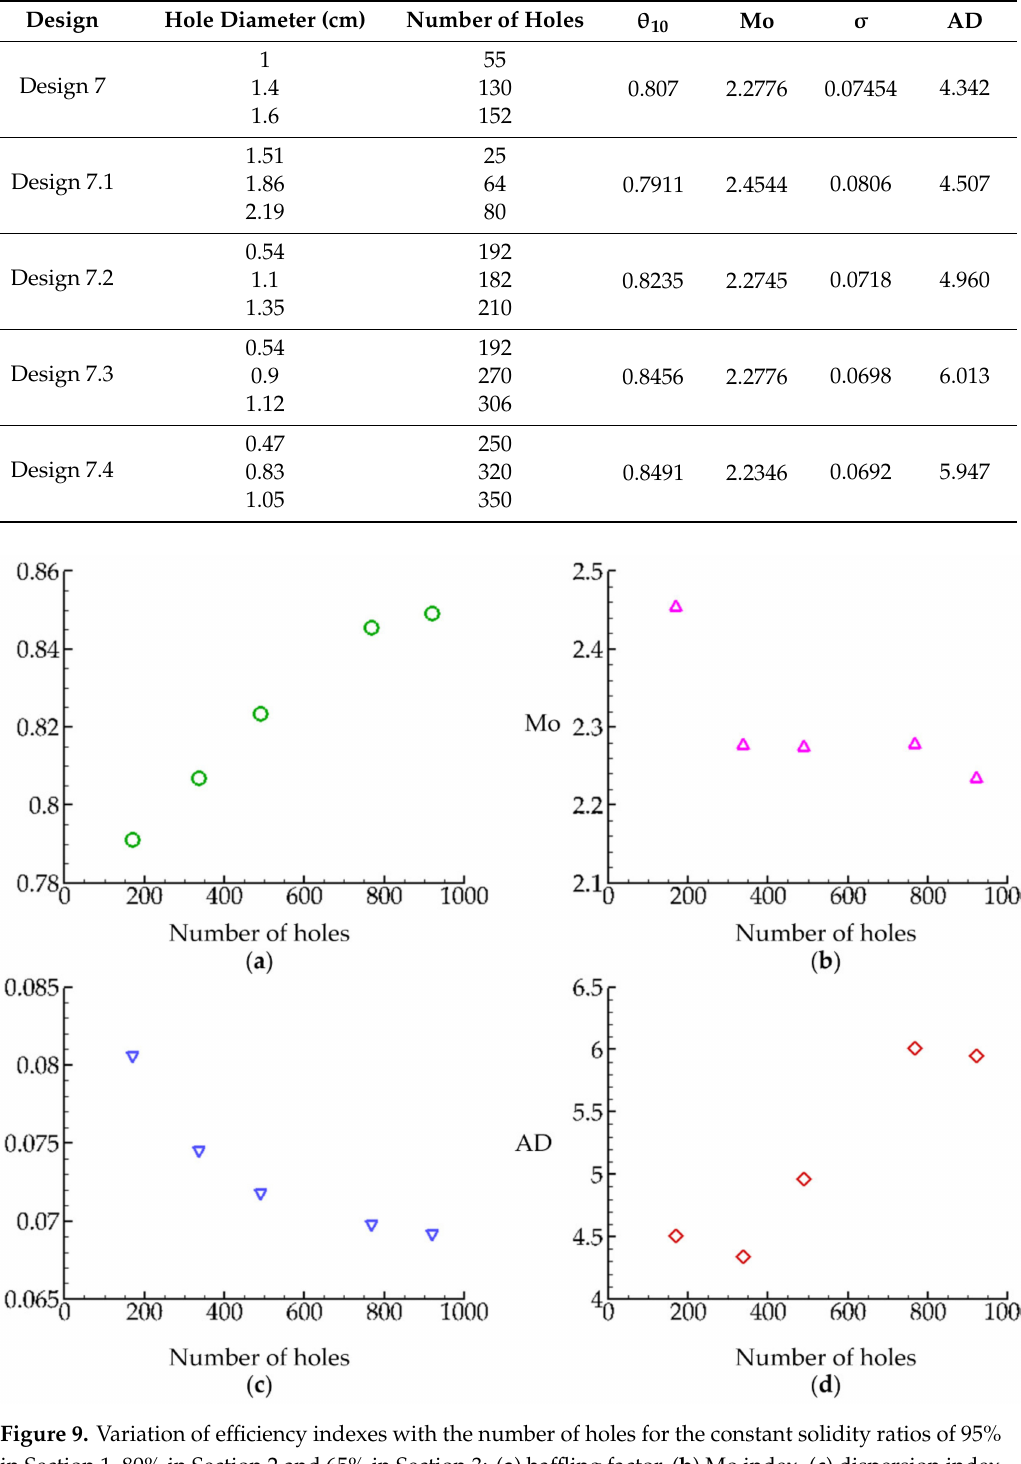
Table 5. Perforation parameters and calculated e ffi ciency indexes for new designs.